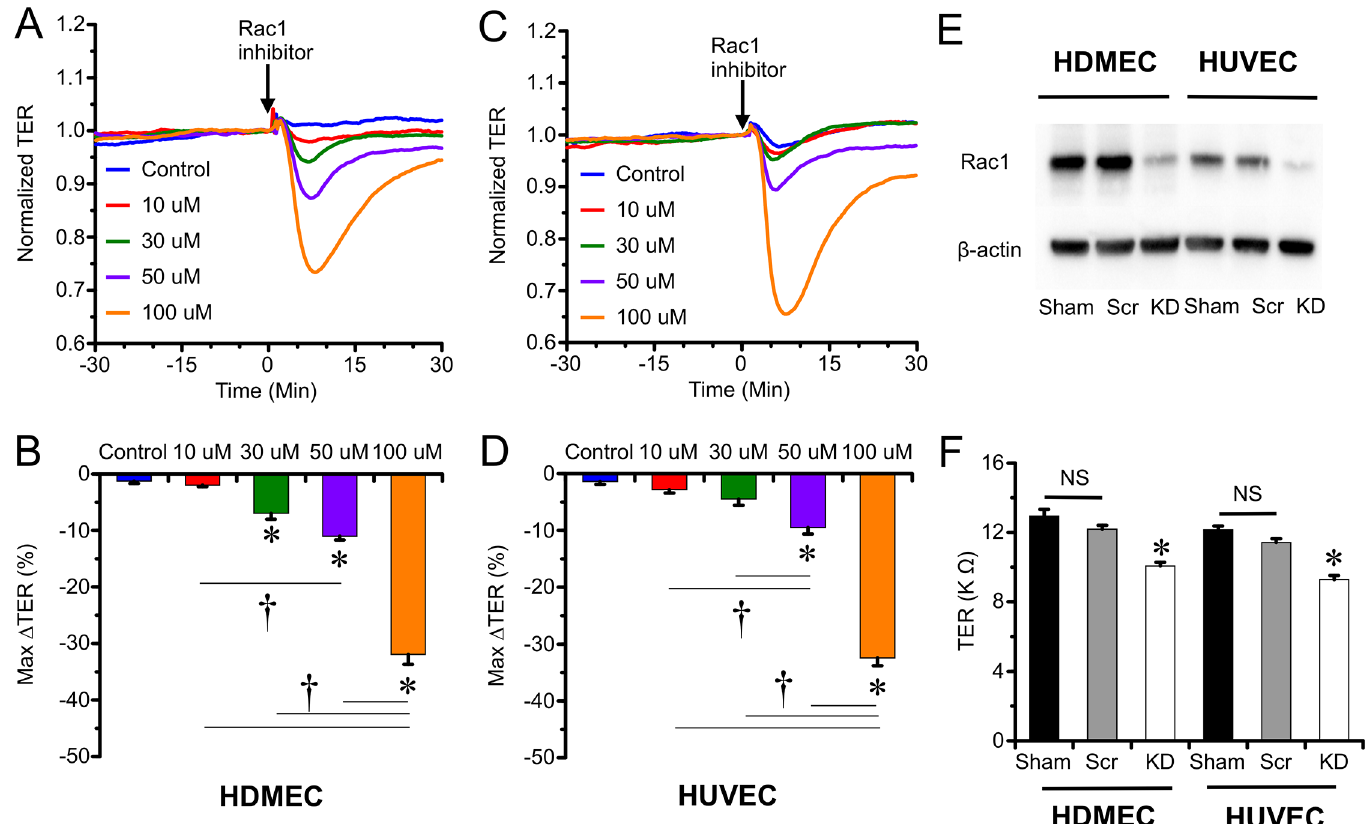
Fig 1. Pharmacological inhibition or siRNA-mediated knockdown of Rac1 impaired baseline endothelial barrier integrity. A . Treatment with the selective Rac1 inhibitor Z62954982 reduces TER in a concentration-dependent manner in HDMEC monolayers. B . Comparison of the mean maximum decreases in TER in the 30-min time window for each concentration of Z62954982 in HDMEC monolayers. Panels C & D show that Z62954982 produces a similar concentration-dependent TER in HUVEC monolayers. E . Western blot confirming knockdown (KD) with Rac1-specific siRNA, compared to sham and scrambled RNA (Scr) control groups. Bands for β -actin from re-probed blots confirmed equivalent loading of protein for each lane. F . Mean baseline TER values of HDMEC and HUVEC monolayers in Rac1 knockdown, scrambled control, and sham-transfected groups. * P < 0.05 versus vehicle treated group. † P < 0.05 versus other concentrations.